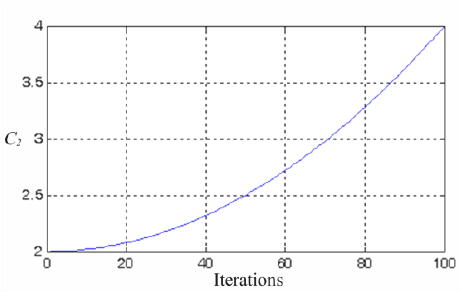
Figure 6. Trend of the social learning factor ( C 2 ) of the modified PSO.